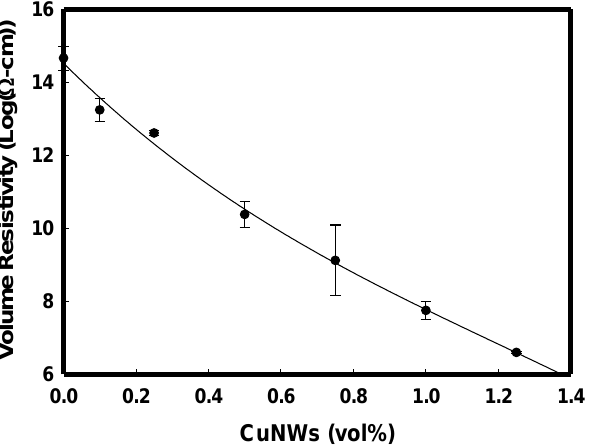
Figure 10. The CuNWs content is dependence on the volume resistivity for various i-PP/CuNWs composites.